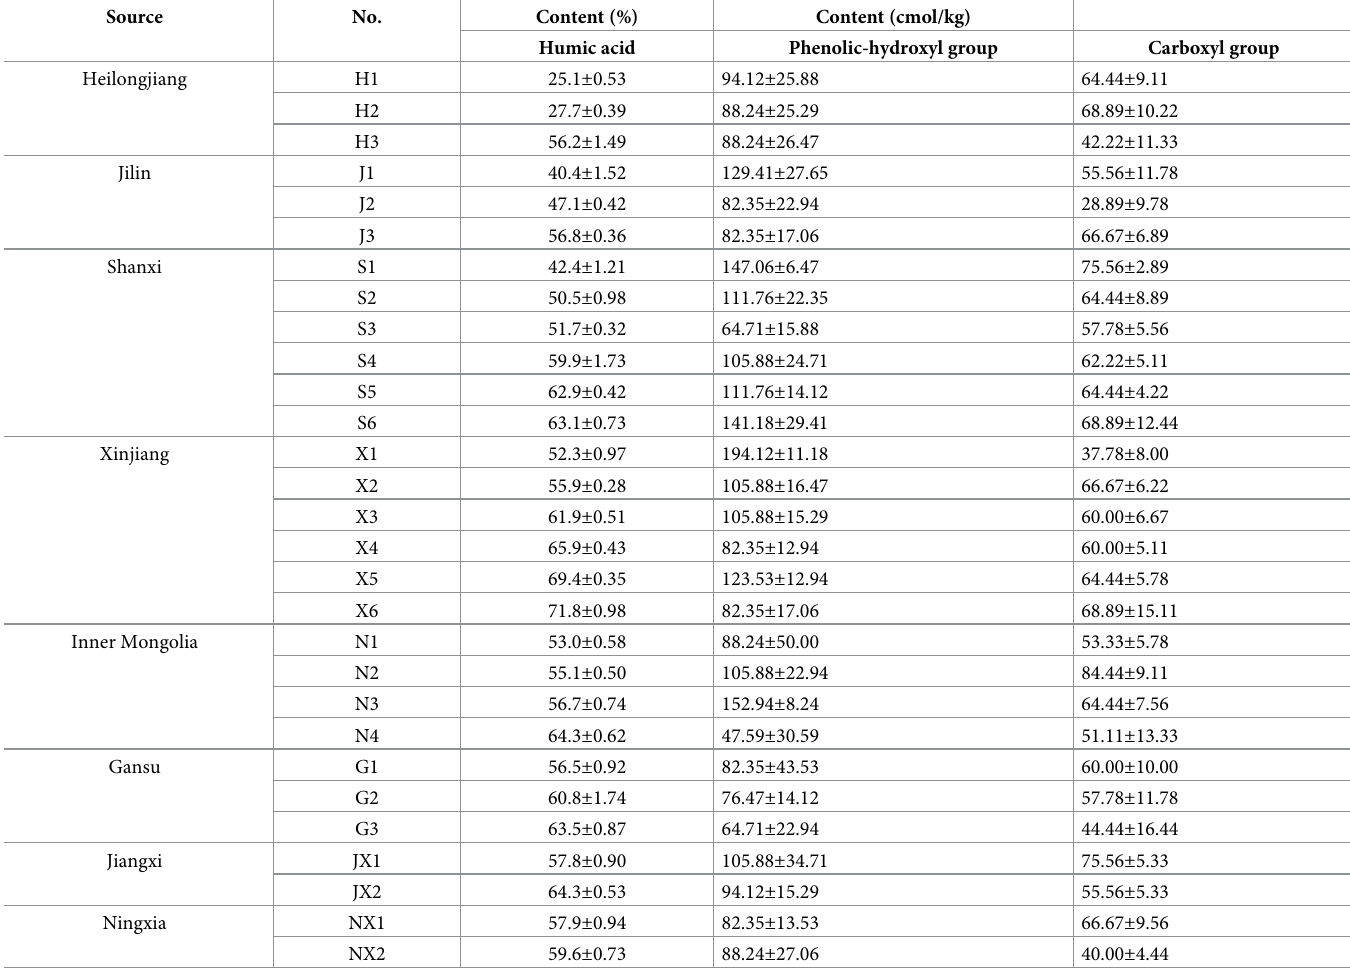
Table 2. Analysis of humic acid products from different regions of